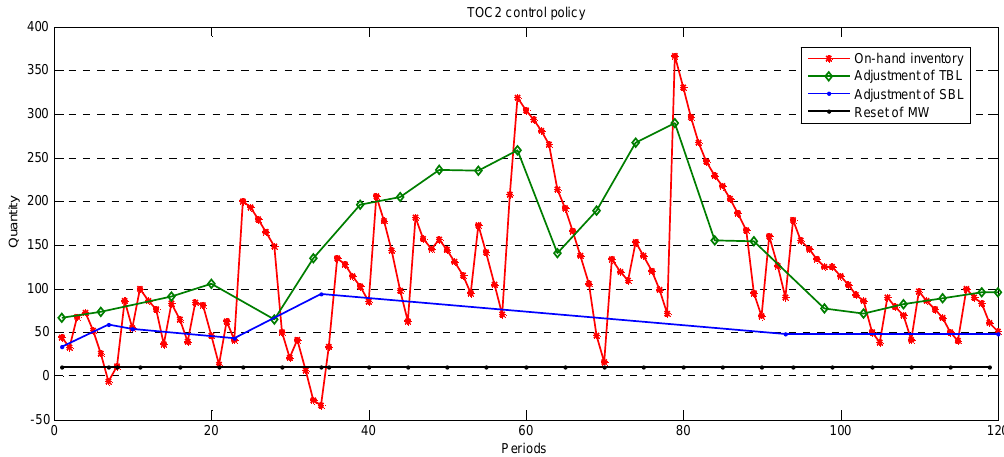
Fig.15. Inventory adjustment process under TOC2 control policy